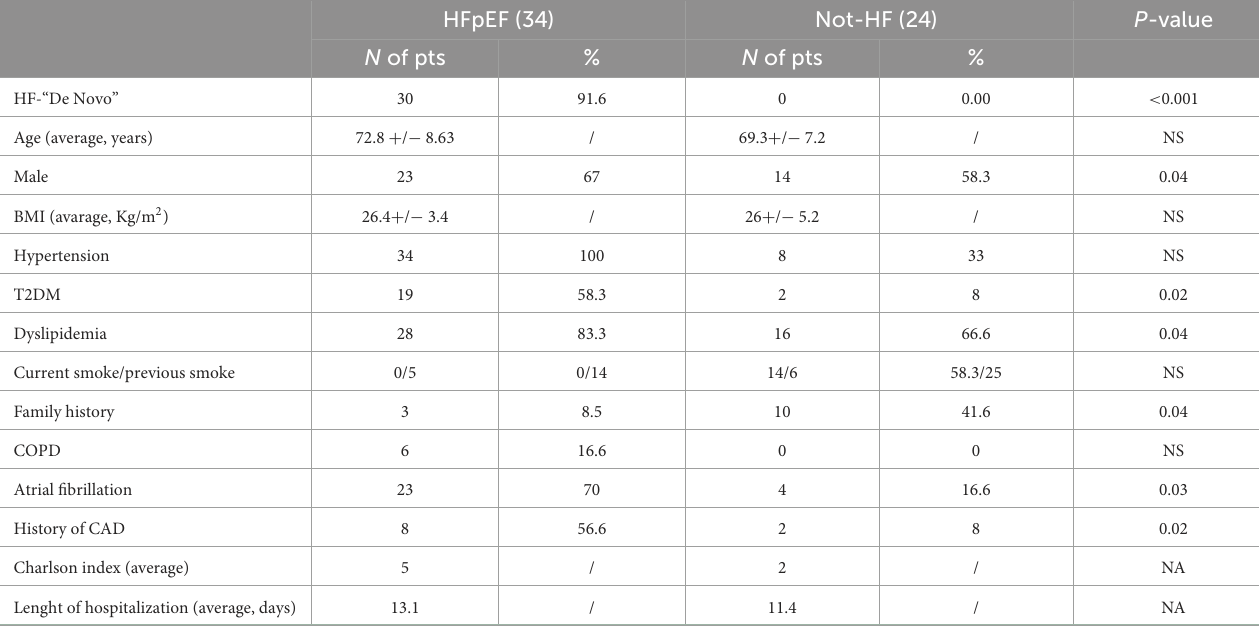
TABLE 1 Clinical characteristics of the patients enrolled.